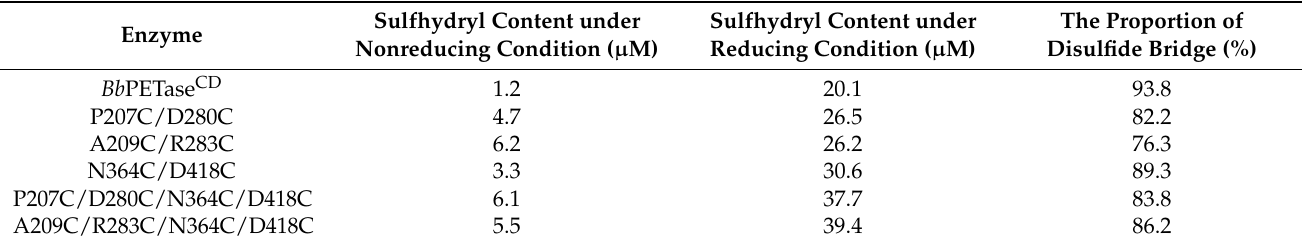
Table 1. Proportion of disulfide bridge of Bb PETase CD and its